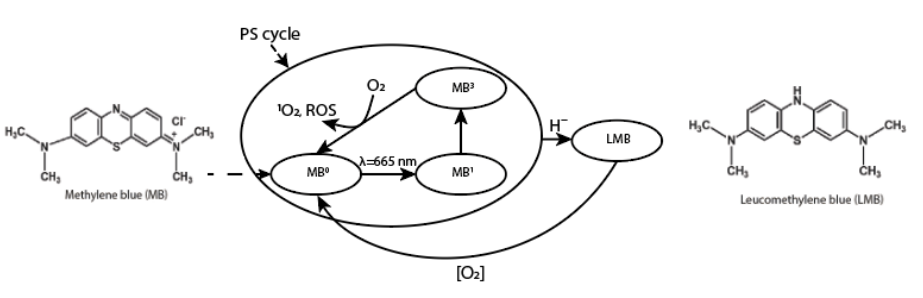
Figure 2. A simplified diagram of MB working in the human body. The uniqueness of the PDT method is based on the cellular response induction to biological structures damage by ROS—natural regulators of cell proliferation, metabolism, and apoptosis. As a result of PDT, mediators that provoke a local inflammatory reaction and cytotoxic activity of immunocompetent cells in relation to the oncological disease are released. Likewise, MB functions as an alternative electron carrier in mitochondria, which accepts electrons from NADH or FADH 2 and transfers them to coenzyme Q10 (CoQ) or cytochrome-c (Cyt-c), bypassing complex I/III blocking (Figure 3) [22]. In addition, McDonagh E.M et al. showed that the mechanism of action of MB is dependent on the intracellular capacity for NADP/NADPH recycling [23].